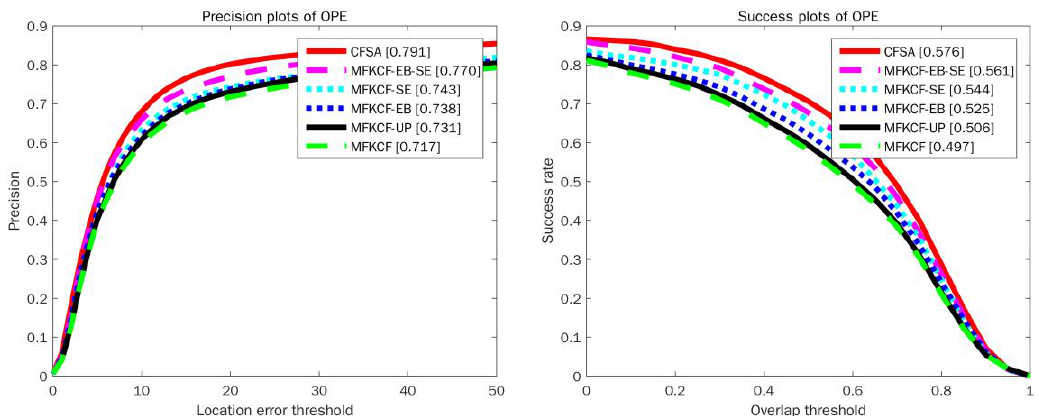
Figure 6. Comparison of three components. Precision and success plots on OTB-100 benchmark dataset using OPE are shown.